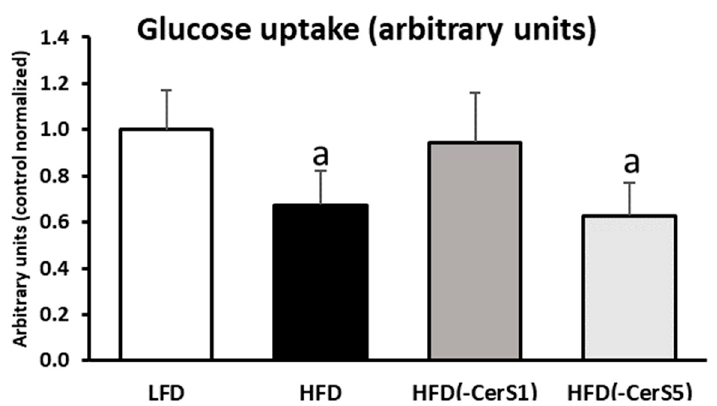
Figure 6. The impact of CerS1 and CerS5 gene silencing on mouse gastrocnemius muscle insulin- stimulated glucose uptake. Values are mean ± SD ( n = 8 per group); a— p < 0.05 vs. LFD; b— p < 0.05 vs. HFD; significance by ANOVA; LFD-low-fat diet, HFD—high-fat diet.